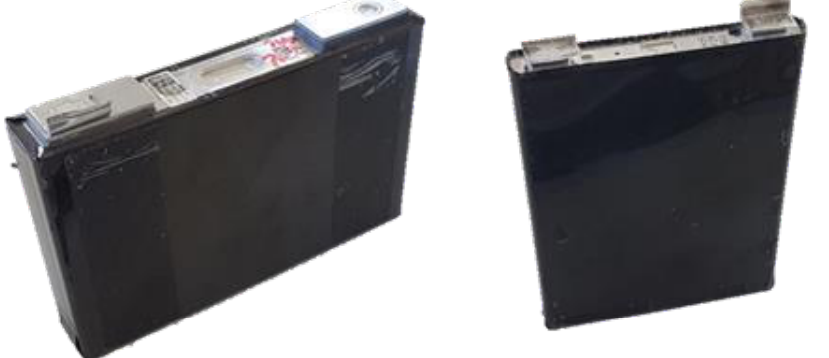
Table 1. Types of lithium-ion battery cells studied.